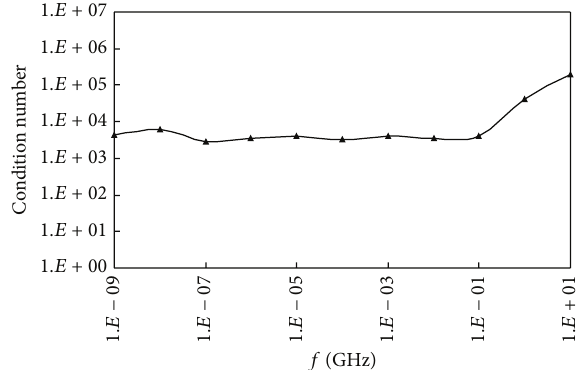
Figure 3: The condition number versus frequency for the A-EFIE with charge neutrality enforcement for the PEC sphere.